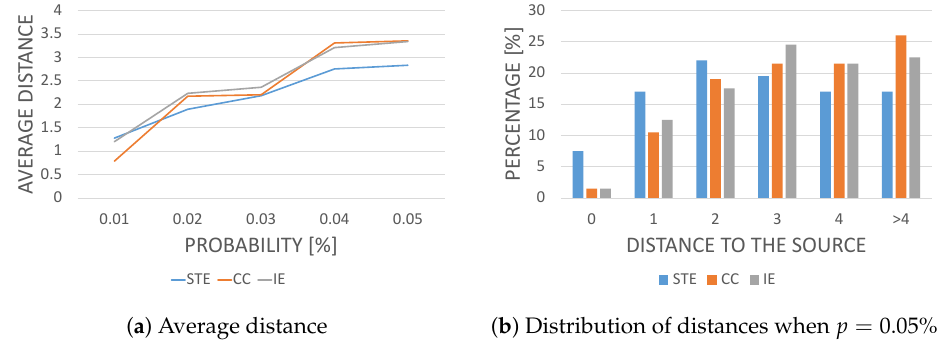
Figure 5. Performance of STE, CC, and IE in p -edge